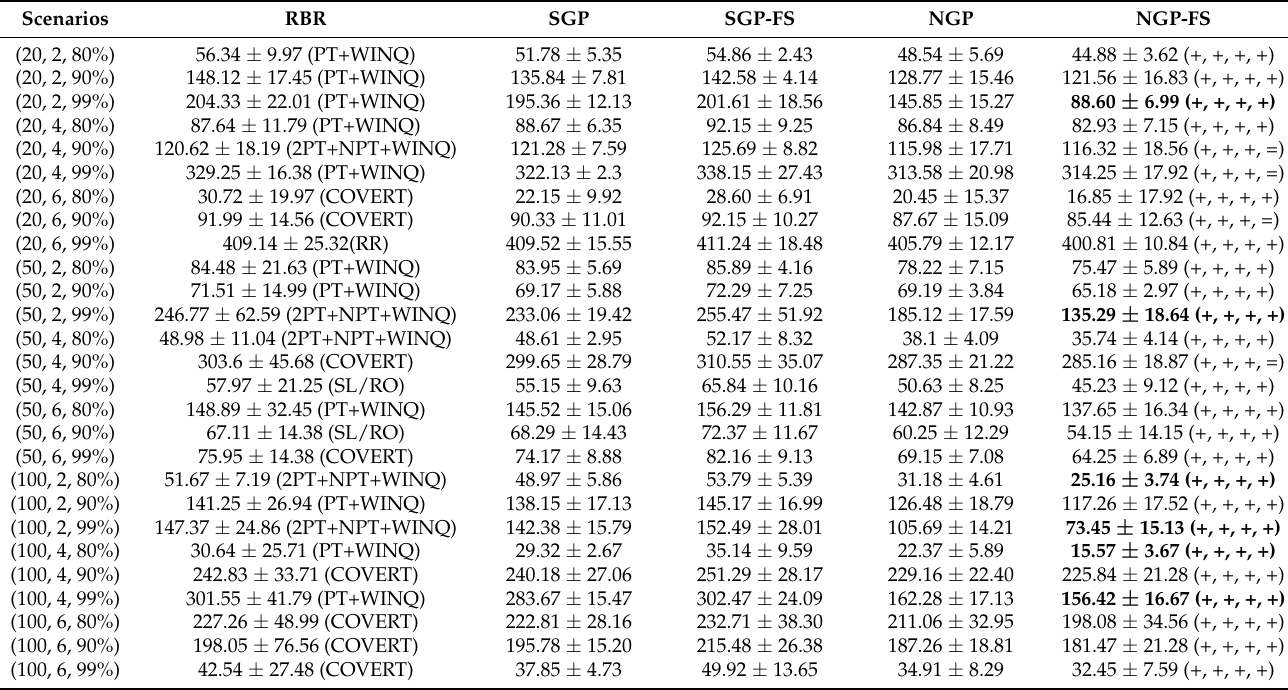
Table 6. Mean and standard deviation of the MT objective value of the considered algorithms in the testing